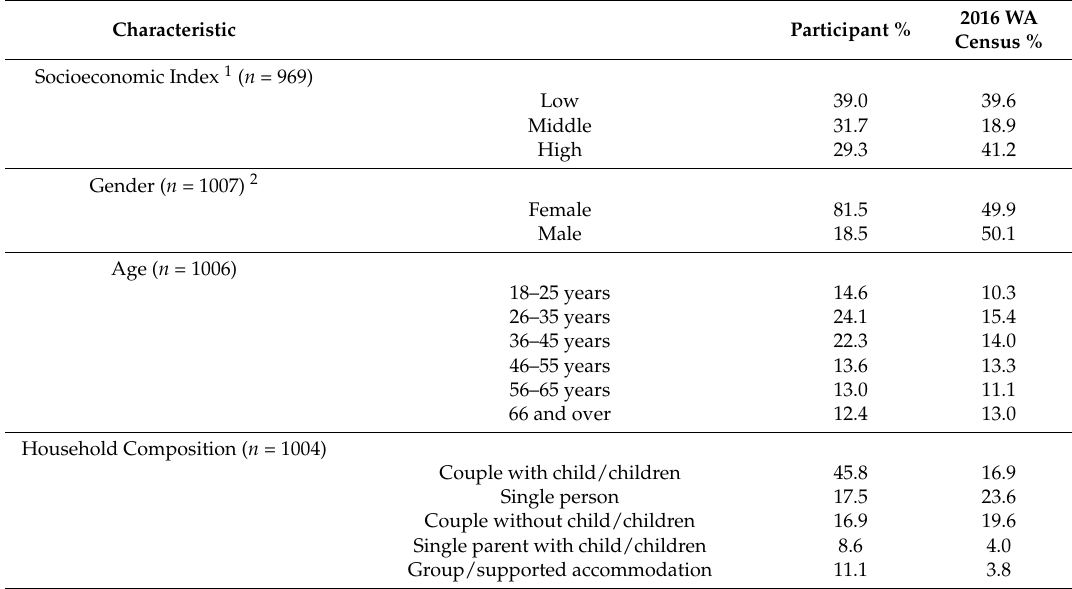
Table 2. Demographic characteristics of program participants based on questionnaire